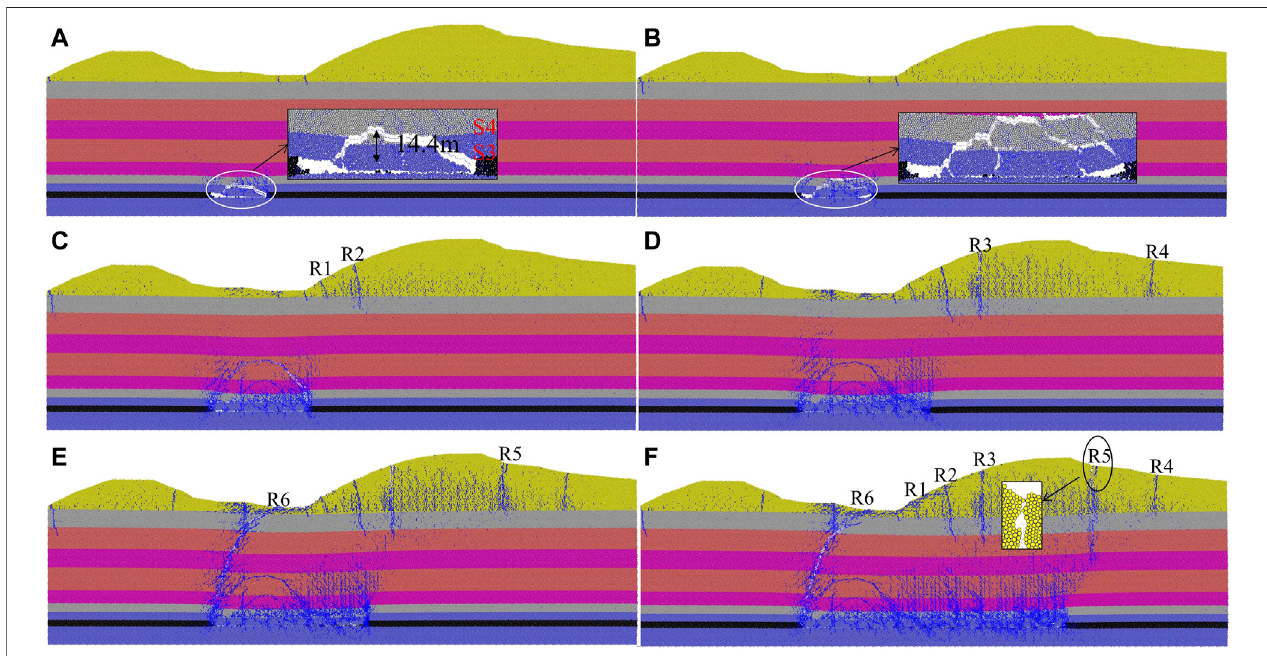
FIGURE8| Evolutionoftheoverlyingstrata at different advancing distances. (A) Advanced to80m. (B) Advanced to100m. (C) Advancedto140m. (D) Advanced to 180m. (E) Advanced to 220m. (F) Advanced to 440m.